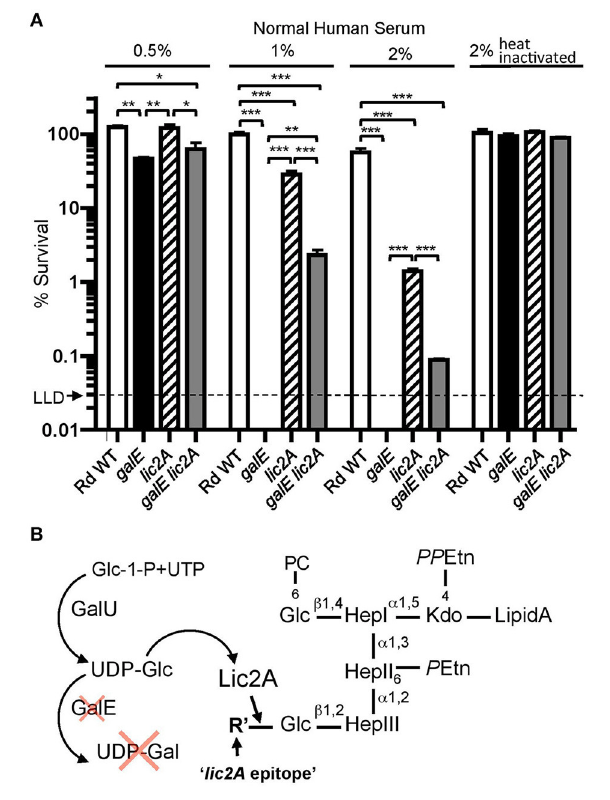
FIGURE 4 | Deletion of lic2A increases serum resistance of the galE mutant. (A) Survival of Rd wild-type (WT) and isogenic single deletion mutants galE , lic2A and double deletion mutant galE lic2A grown in sBHI medium was assayed following incubation with 0.5, 1, and 2% NHS at 37 ◦ C for 30min. Percent survival is the ratio of CFU recovered from samples treated with either NHS or NHS 1 i at 30min to CFU recovered from untreated samples. Log-transformed survival ratios were evaluated by one-way ANOVA with Bonferroni’s multiple comparison test (* p < 0.05; ** p < 0.01; *** p < 0.001). The mean of triplicate samples is shown. LLD, lower limit of detection. (B) Proposed model to account for complement sensitivity of the galE mutant resulting from addition of a lic2A dependent alternative epitope in the absence of galactose. GalU, glucosephosphate uridylyltransferase, R’ is inferred to be Glc (see Results and